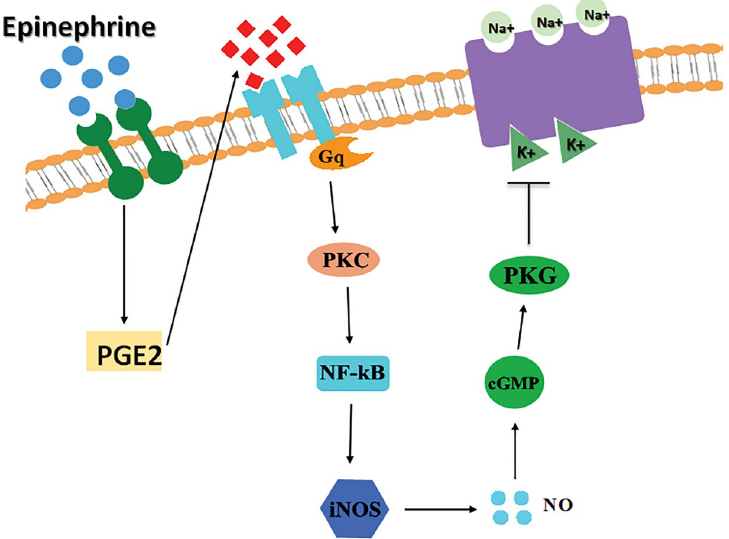
Fig 8. Proposed signaling